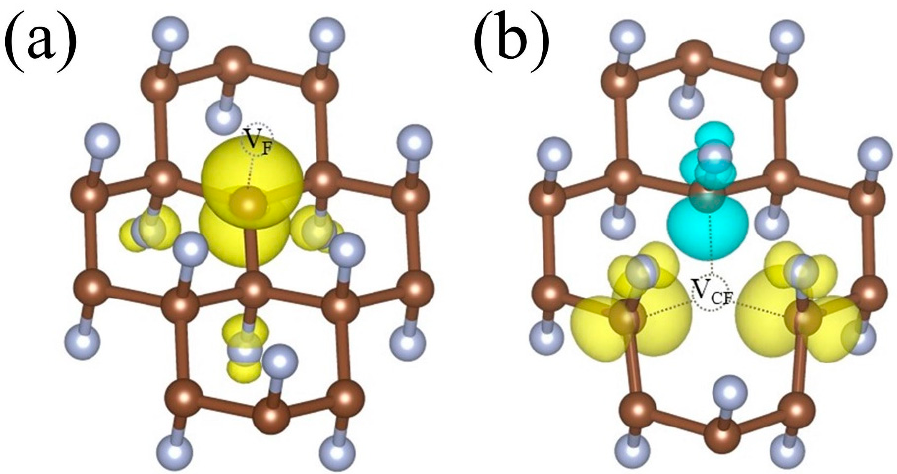
Figure 3. The spin-charge densities n ↑ ( r ) − n ↓ ( r ) in ( a ) V F -fluorographene and ( b ) V sCF -fluorographene. Yellow and blue colors represent spin-up and spin-down isosurface, respectively. The electronic properties of fluorographene and fluorographene with vacancy